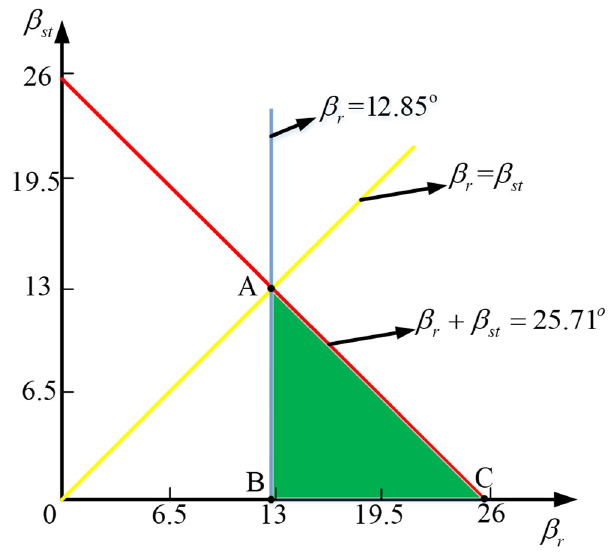
Figure 4. Feasible range of the rotor pole arc and torque pole arc .